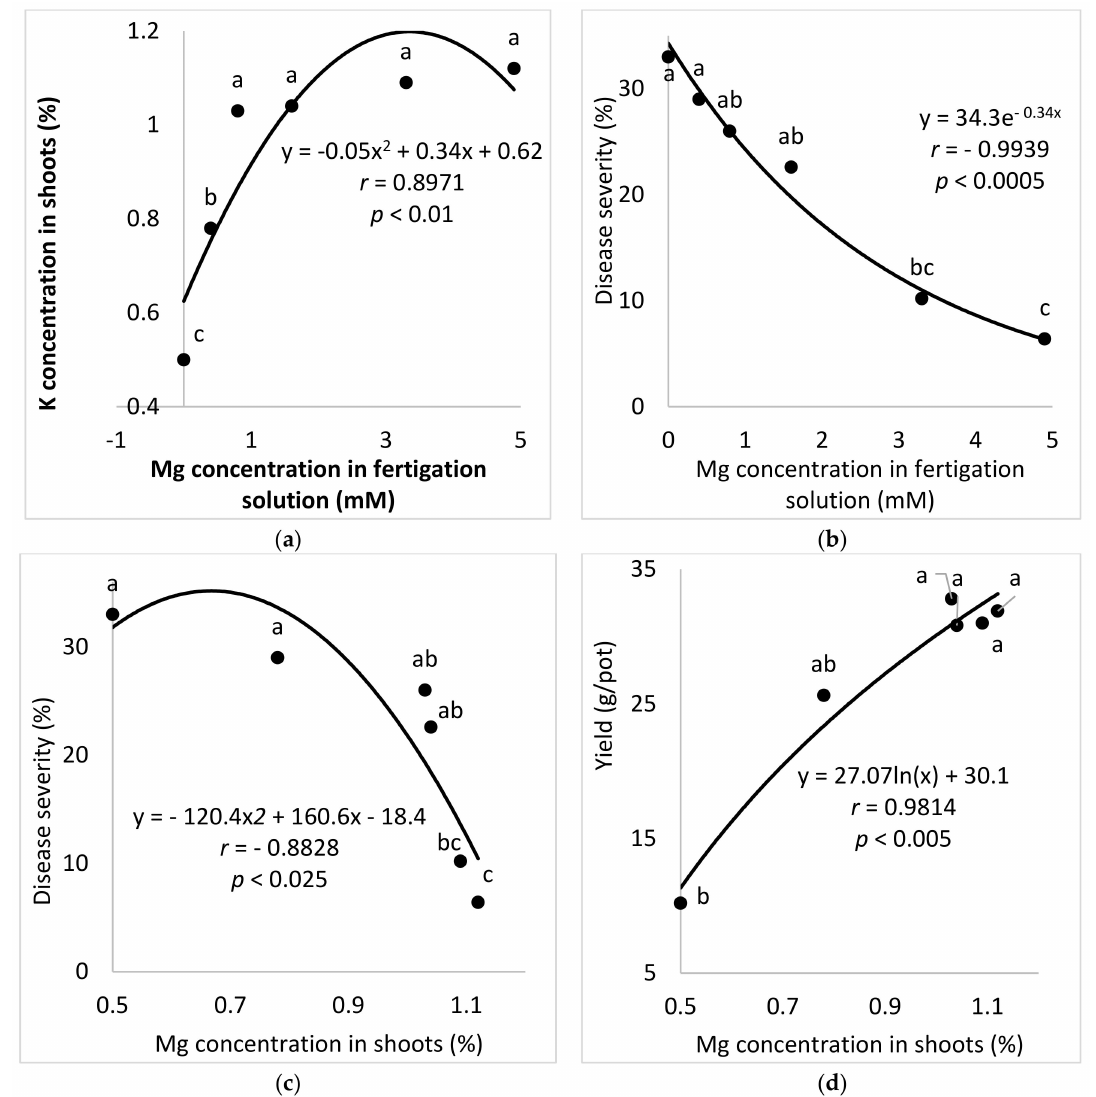
Figure 4. Effects of the Mg concentration in the fertigation solution on ( a ) the Mg concentration in the sweet basil shoots, ( b ) the severity of sweet basil downy mildew (SBDM) and ( d ) yield. SBDM severity is described in relation to ( b ) the Mg concentration in the fertigation solution and ( c ) the shoots. SBDM severity was evaluated on a 0–100% scale, in which 0 = healthy plants and 100% = plants completely covered by SBDM symptoms/signs. Data derive from 3 trials ( n = 10). In each graph, values for each Mg treatment followed by a common letter are significantly not different from each other according to Tukey–Kramer’s HSD test ( p ≤ 0.05). The correlation formulas and Pearson regression values ( r ) are presented along with significance levels ( P ). Bar =